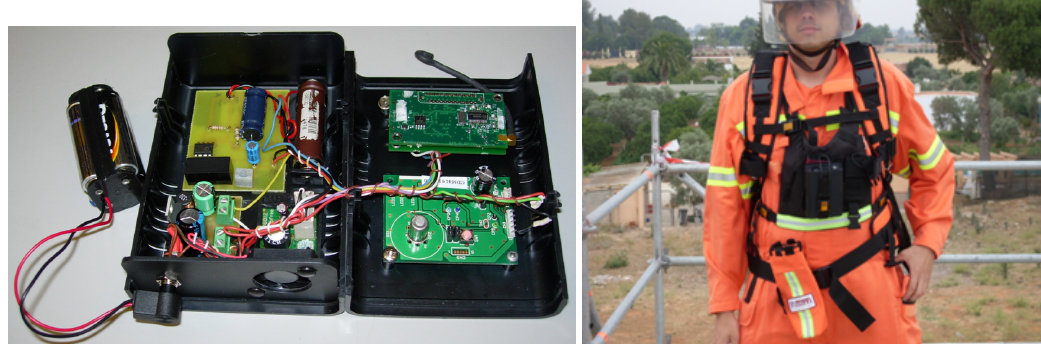
Figure 1. ( Left ) Prototype of the mobile nodes used in the experiments; ( Right ) Photograph taken during the validation